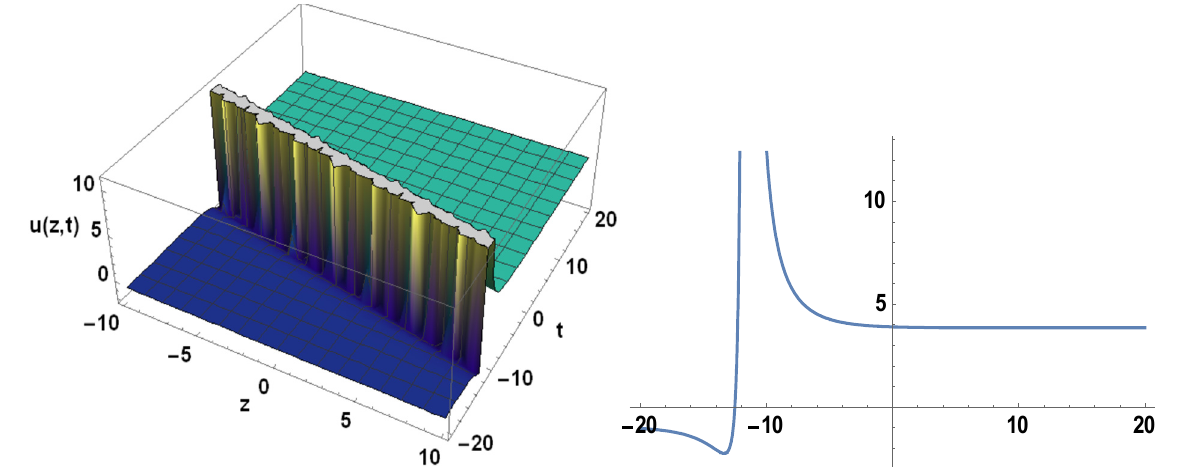
Figure 11. The 3D and 2D plots of Equation (61) for various values of parameters.